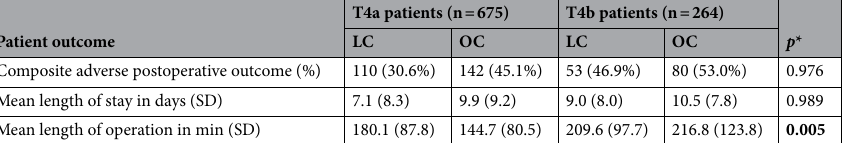
Table 3. Effect of laparoscopic versus open colectomy by type of T4 tumor, NSQIP 2013–2015. * p < 0.05 based on propensity score-matched patients comparing T4a versus T4b patients. LC: laparoscopic colectomy; OC: Open colectomy; SD: standard deviation. Composite outcome includes readmission, reoperation, wound infection, blood transfusion, prolonged ileus, sepsis, myocardial infarction, deep vein thrombosis, pulmonary embolism, and